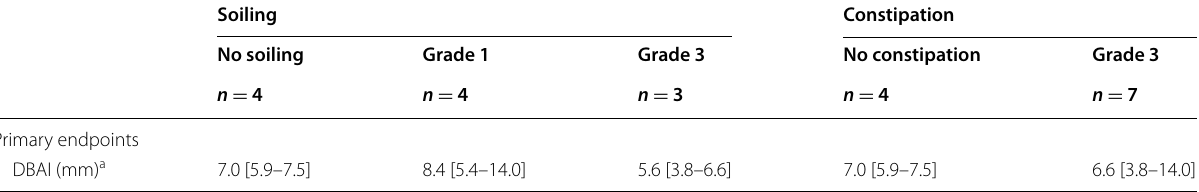
Values are presented as median [range] or number (%) a DBAI distance between the anastomosis and intersphincteric groove